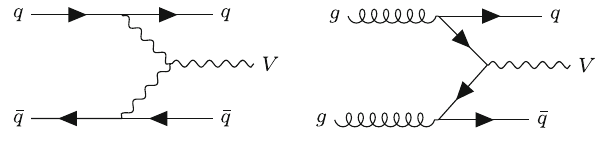
presence of color exchange between the two incoming par-